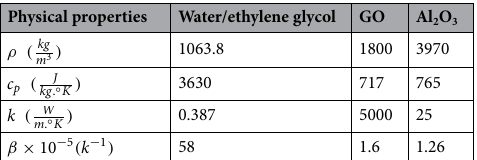
Table 1. Details of nanoparticles utilized in the present